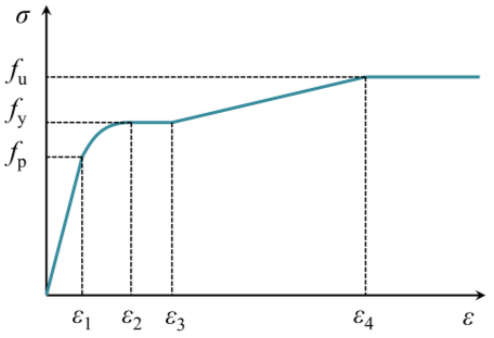
Figure 1. Stress–strain relationship for steel.